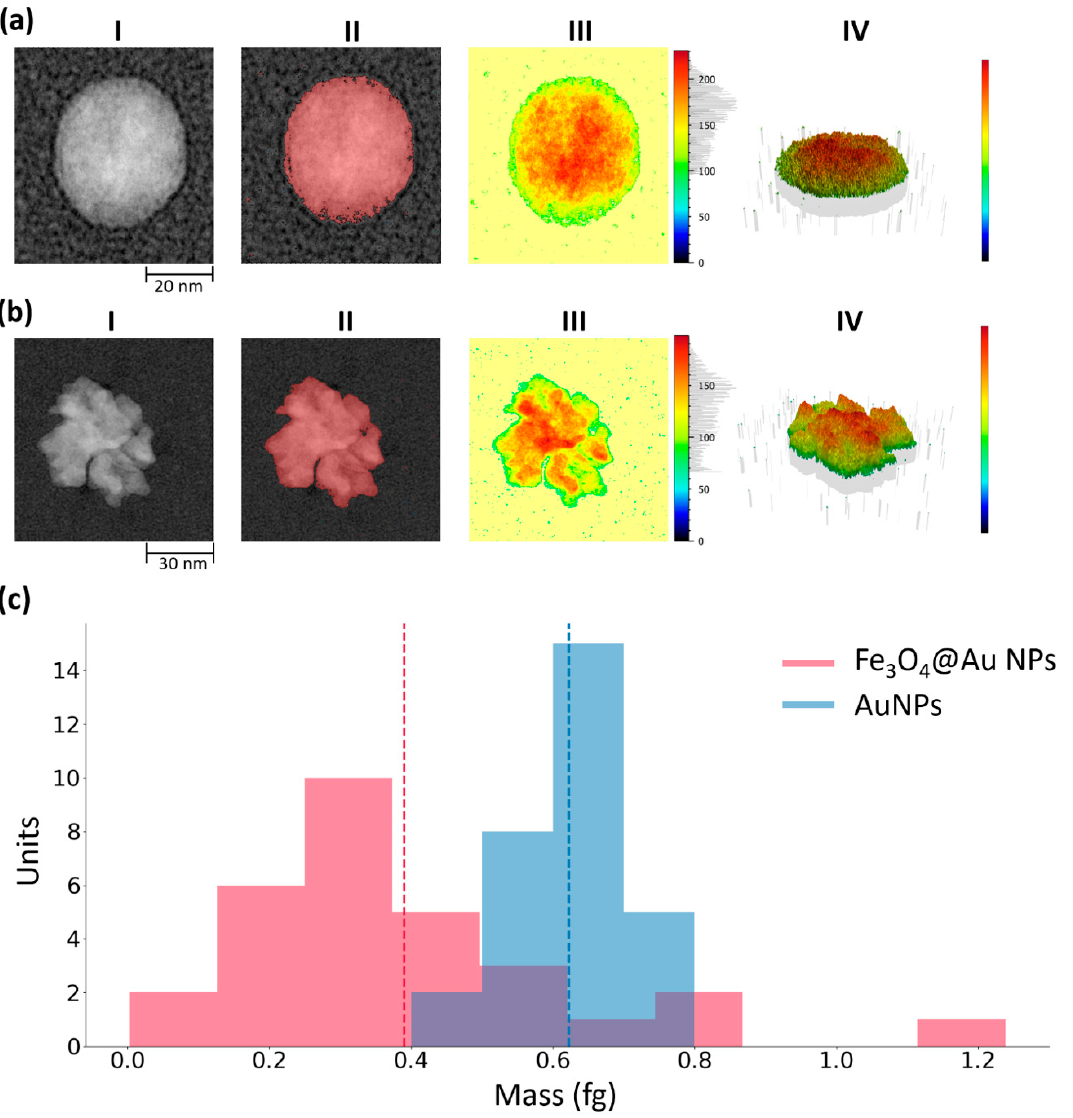
Figure 2. The steps of the protocol employed to estimate the mass of AuNPs ( a ) and Fe 3 O 4 @Au NPs ( b ) using the software SPIP Mountains 8. The nanoparticle of interest was considered and extracted from the collective TEM micrograph ( I ), the contour of the nanoparticles was detected and distinct by the background ( II ), then particle surface ( III ) and its 3D rendering ( IV ) were generated. The latter was employed to estimate the volume of the object. ( c ) Mass distribution of AuNPs and Fe 3 O 4 @Au NPs (core-shell NPs). The mean and the standard deviation for the mass distributions were 0.4 ± 0.2 fg for Fe 3 O 4 @Au NPs and 0.63 ± 0.09 fg for AuNPs. Each nanoparticle employed for the mass analysis was extracted randomly from collective TEM micrographs.